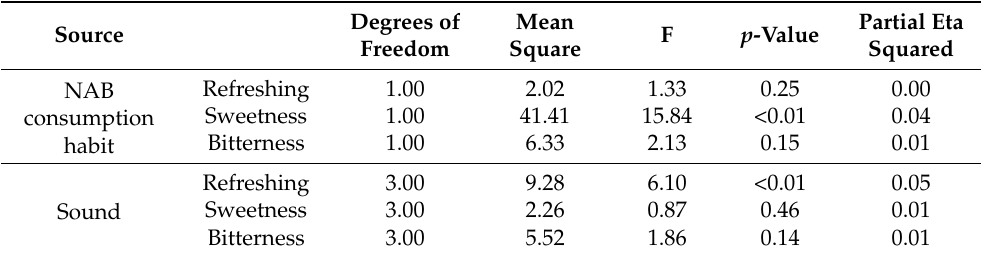
Table 8. Summary of the results of the univariate tests at the between-participants level on each sensory expectation in Experiment